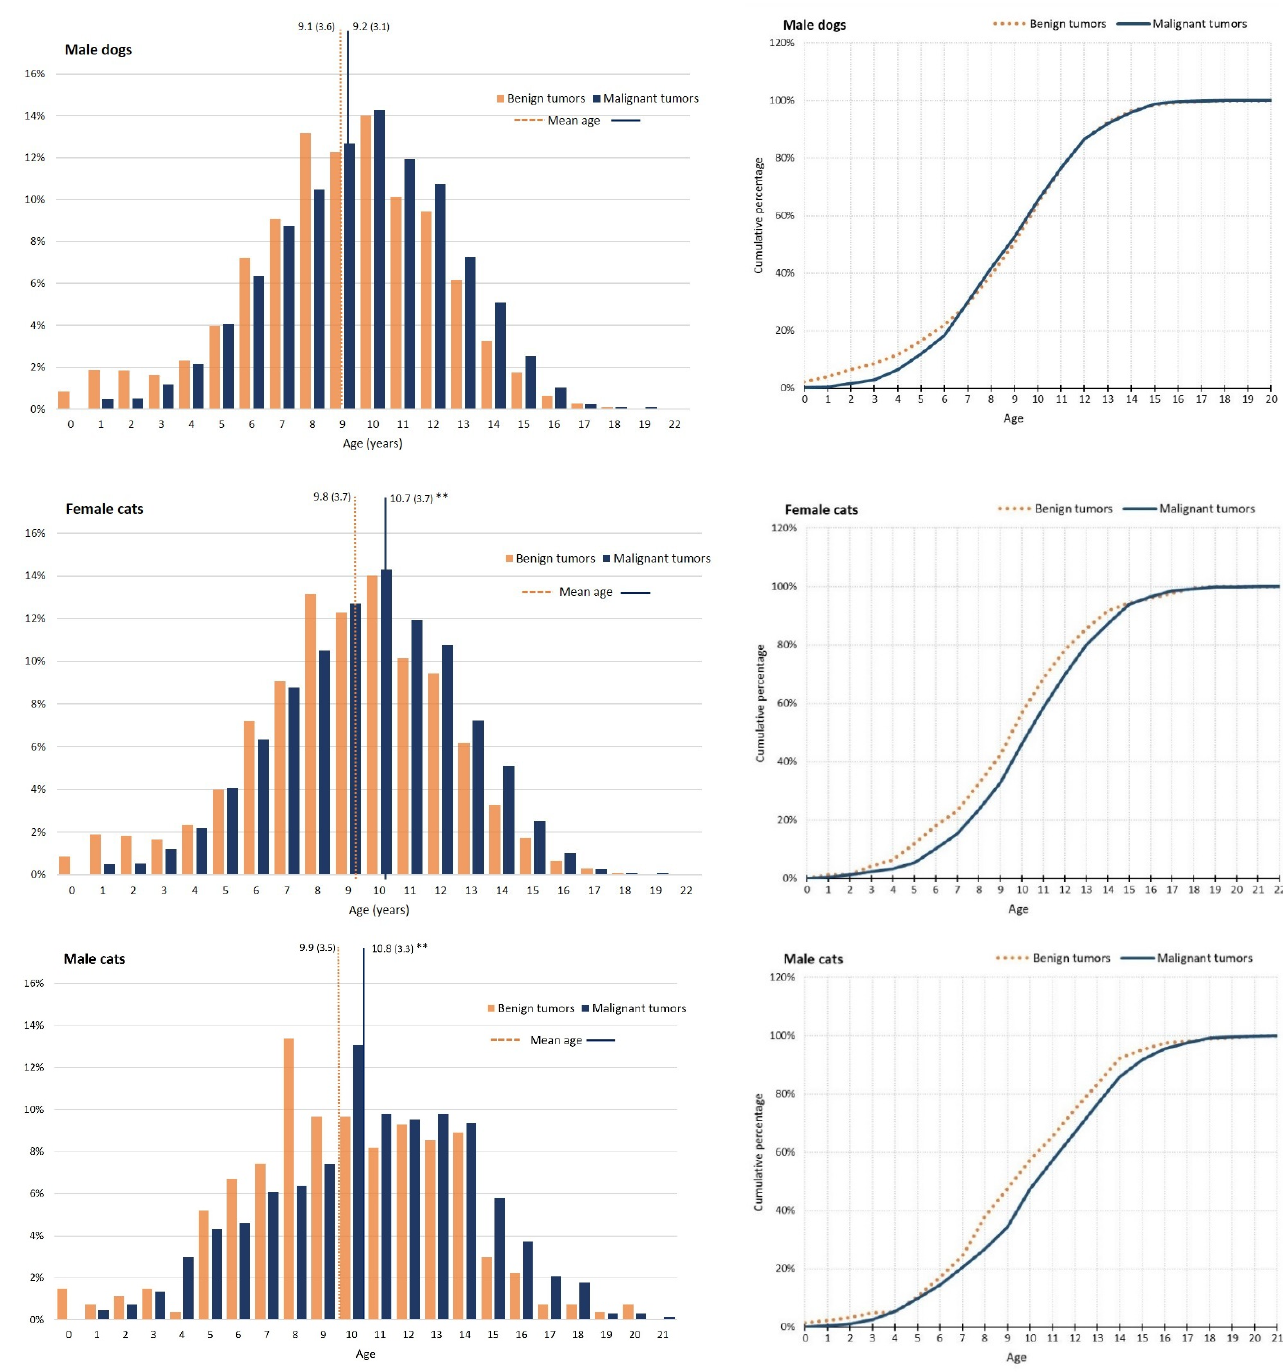
Figure 1. Age distribution (in percentage, ( left )) and cumulative proportions ( right ) of benign and malignant tumors in dogs and cats, by sex. Dotted lines in the left graphics represent mean ages of benign and malignant tumors. ** p < 0.001, t-test.